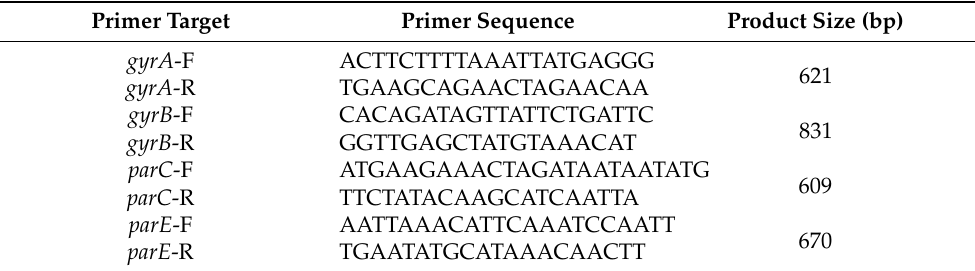
Table 3. Primers and sequences of the genes coding for